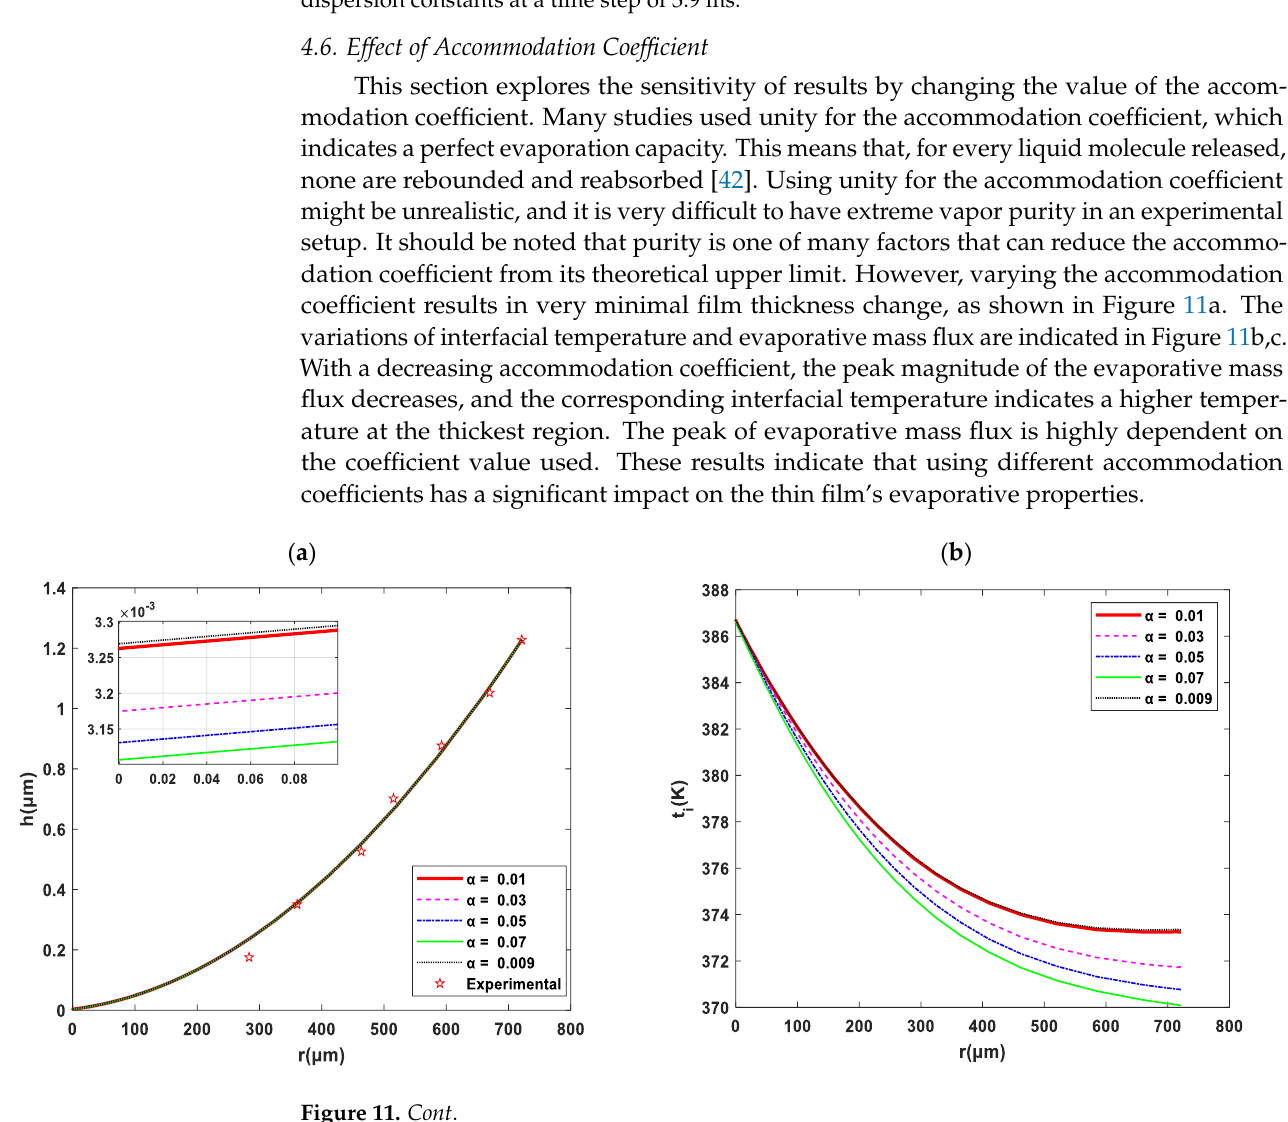
Figure 10. Radius evolutions of ( a ) disjoining pressure; and ( b ) evaporative mass flux for different dispersion constants at a time step of 3.9 ms.